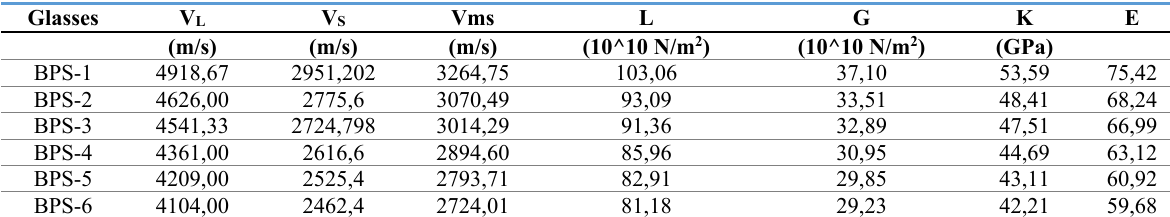
Table 2 L ongitudinal Velocity (V L ), Transverse velocity (V s ), Average sound velocity (V ms ), Longitudinal Module (L), Transversal Modulus (G), Bulk Module (K) e Young's Module (E).